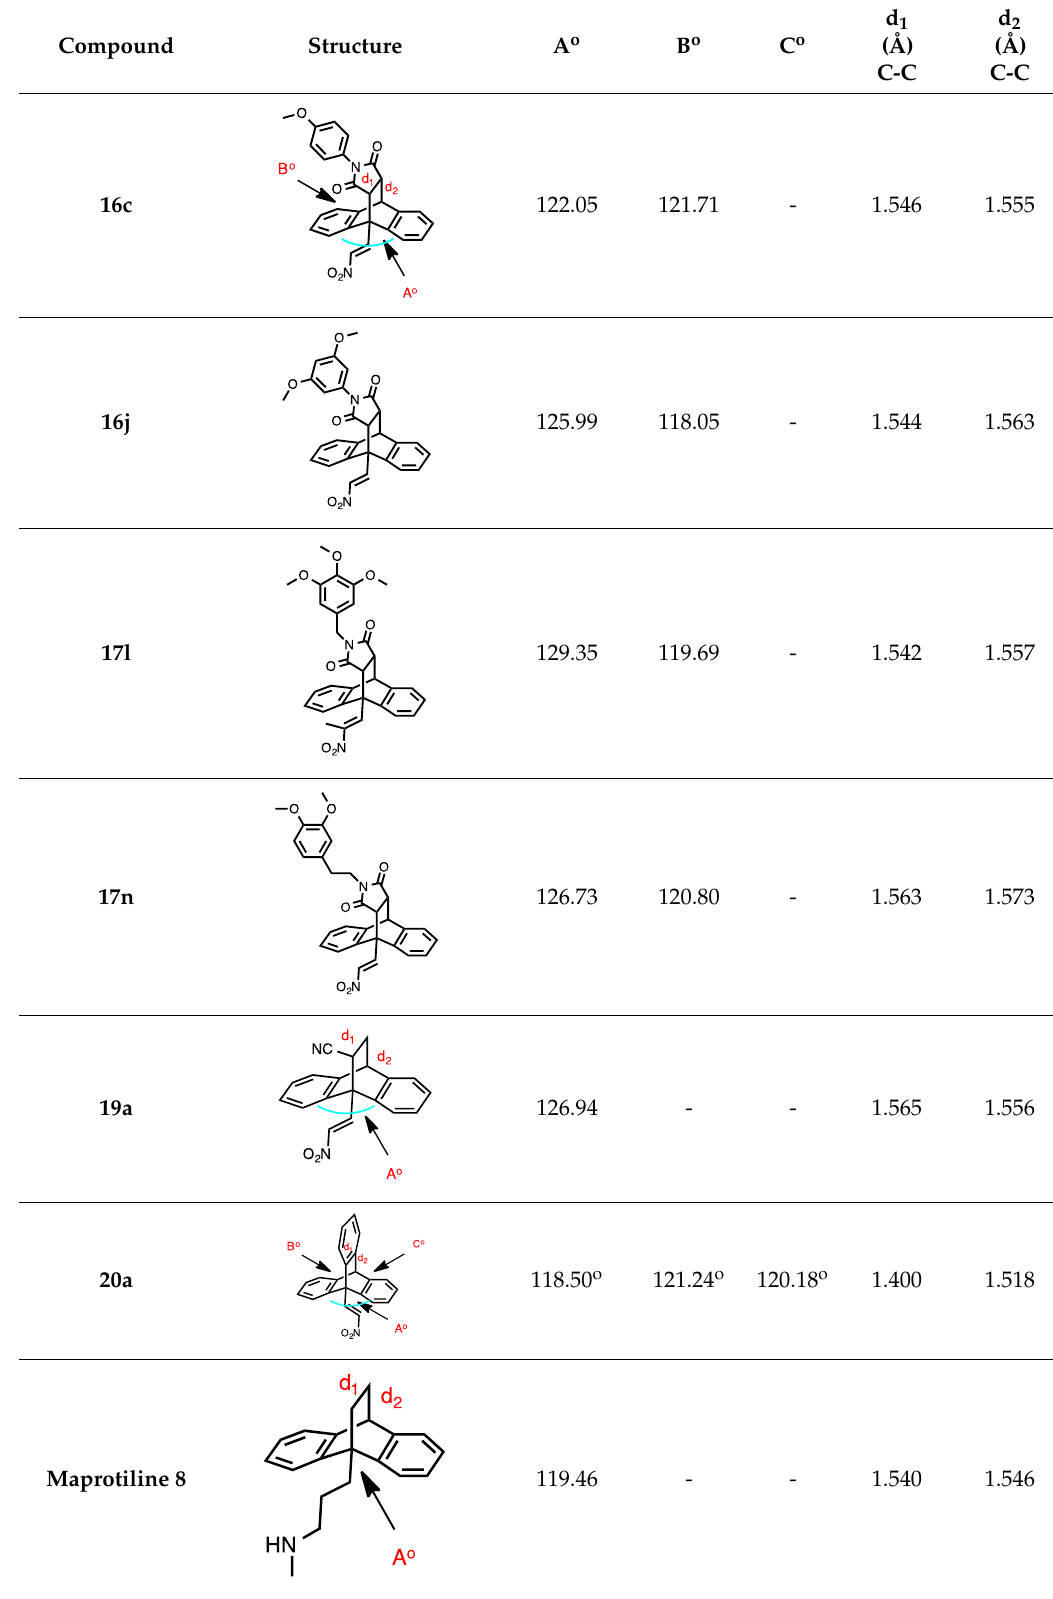
Table 4. X-ray crystallography data for compounds 16c , 16j , 17l , 17n , 19a and 20a .